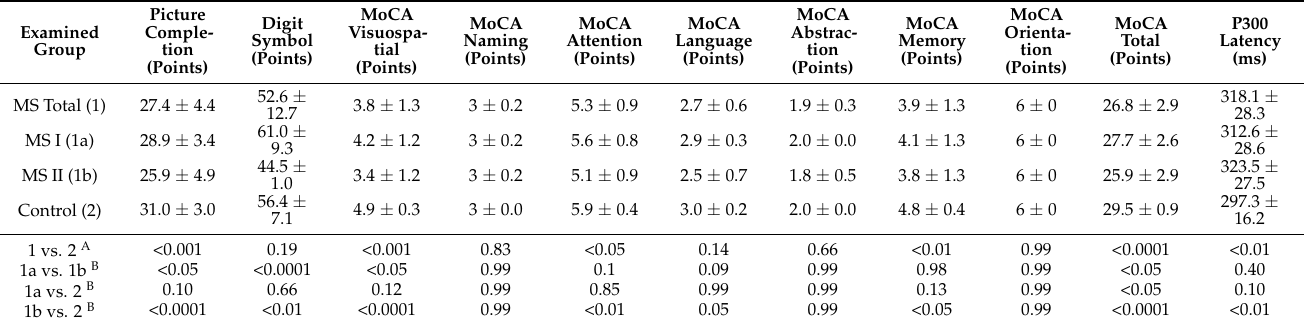
Table 4. Results of psychometric and neurophysiological